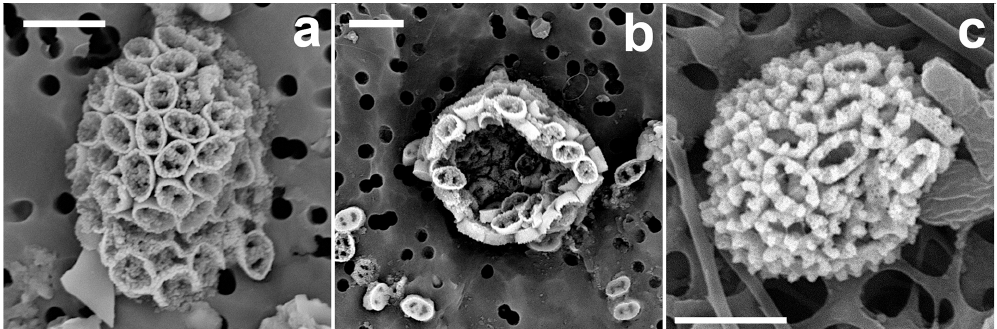
Figure 16. Novel holococcolithophores. (a, b) Calicasphaera bipora (incubated water sampled in the GoA, 18 June 2018, 20m). (c) Holo- coccolithophore A (GoN, 30 November 2016, 10m). Scale bars: